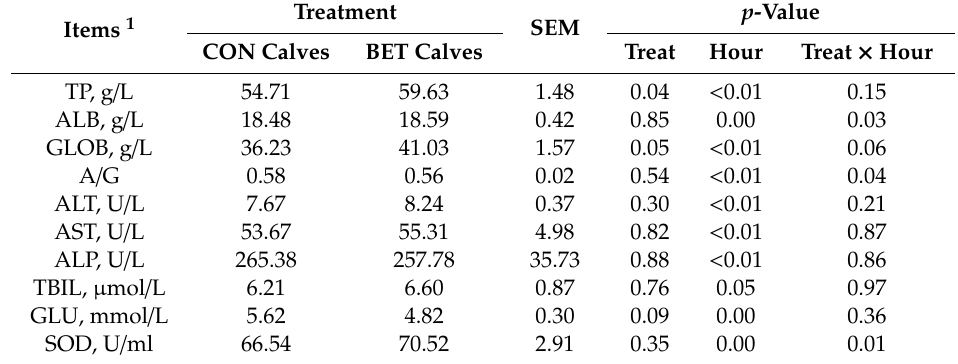
Table 4. The blood metabolites during the 24 h after birth of calves born to dams supplemented without rumen-protected betaine (CON) or with rumen-protected betaine (BET) during the peripartal period. p -Value Treatment SEM Items 1 CON Calves BET Calves Treat